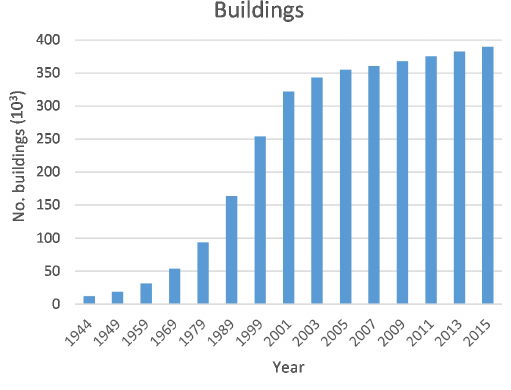
Figure 24. Number of buildings in the governorate of Alexandria from 1944 until